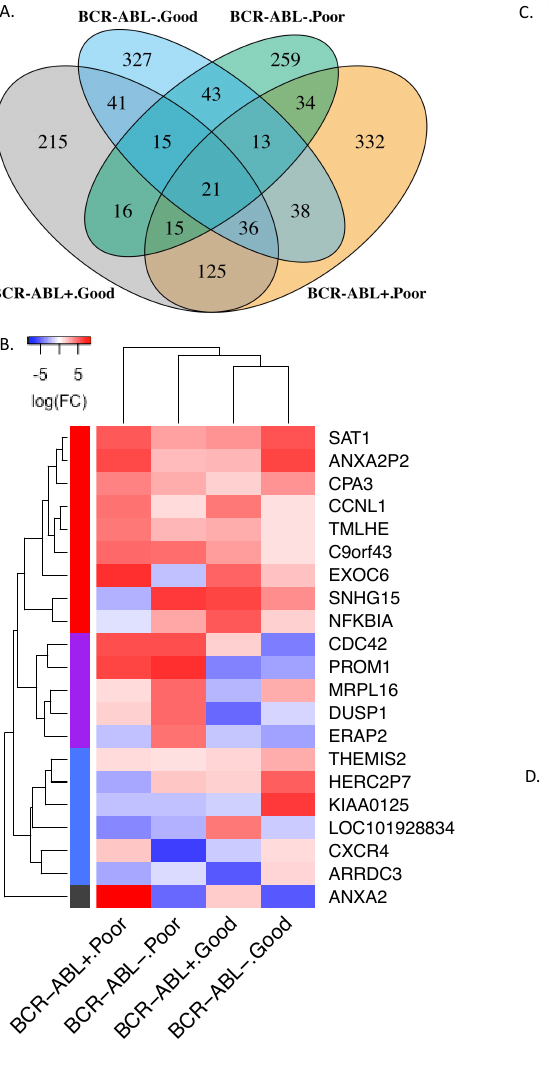
Figure 1. Gene expression and regulation changes in different CP-CML stem cells. ( A ) The pairwise comparisons between normal HSCs and different stem cell groups, which were BCR-ABL + and BCR- ABL − of good responders as well as BCR-ABL + and BCR-ABL − of poor responders, respectively, resulted in four differentially expressed gene sets. ( B ) The hierarchical clusters of the stem cell groups were based on expression changes of 21 common differentially expressed genes. The cells from the patients with the same TKI response (either good or poor) were clustered together. Meanwhile, the genes formed four clusters (red, purple, blue, and grey) according to their expression alteration patterns in different cell groups as compared to normal HSCs. ( C ) The TF regulators of common DEGs were identified from cellular transcription networks. The bold gene names in the table represent the most frequent TF regulators of common DEGs. ( D ) The transcription regulon of ELF1 , one of the most frequent regulators in the transcription networks, controlled four underexpressed genes, shown in blue nodes, in the cells of good responders or normal HSCs, and one overexpressed gene, shown in the red node, in the cells of poor